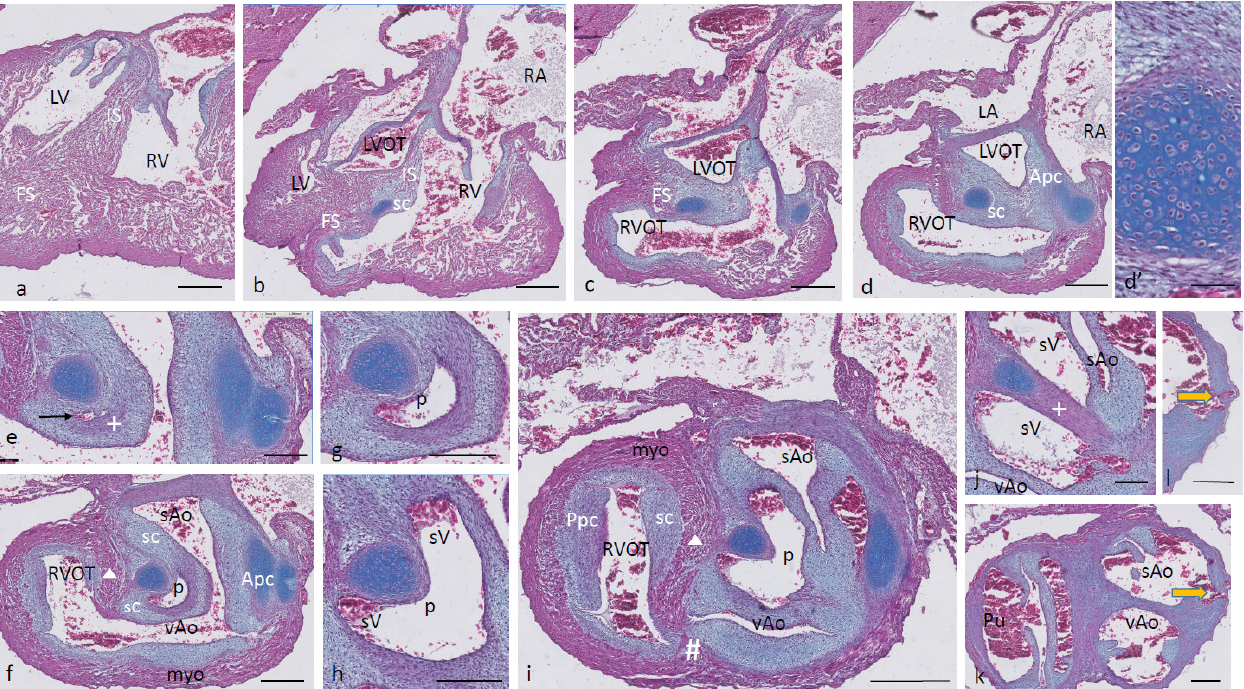
Figure 6. Ferguson stage 24, Figure ( a – l ), from AV valves to semilunar valve level. Figure ( a , b ), the AV cushions have elongated to form free-edged valve leaflets. Figure ( c , d ), folding septum including septal cushion is centrally located between left and right ventricular compartments. Cartilage-rich prongs in both OFT cushions. Note that the parietal cushion now contains two cartilaginous centers. Figure ( d’ ) shows a higher magnification of the hypertrophic chondrocytes. Figure ( e , f , g , h ), the tunnel of the foramen of Panizza (p) is shown rounding the septal cartilage and joining the sinus of Valsalva (sV) of both aortas. Note that the cartilage is surrounded by a fibrous capsule. Figure i , the AP septum is completed. Figure ( j ), the IA septum is completed. Figure ( k , l ), coronary ostia (yellow arrows) are found in the parietal wall of the systemic aorta, but not the visceral aorta. Key to the symbols # ventral myocardium, part of AP septum; * (presumably) left-sided neural crest cells, part of AP septum; + (presumably) right-sided neural crest, part of IA septum; Δ dorsal myocardium, part of AP septum. Magnification Figure ( a , bar 1mm; ( b – d , i ), bar 500 µm; ( e – h , j – l ), bar 200 µm; ( d’ ), bar 50 µm.